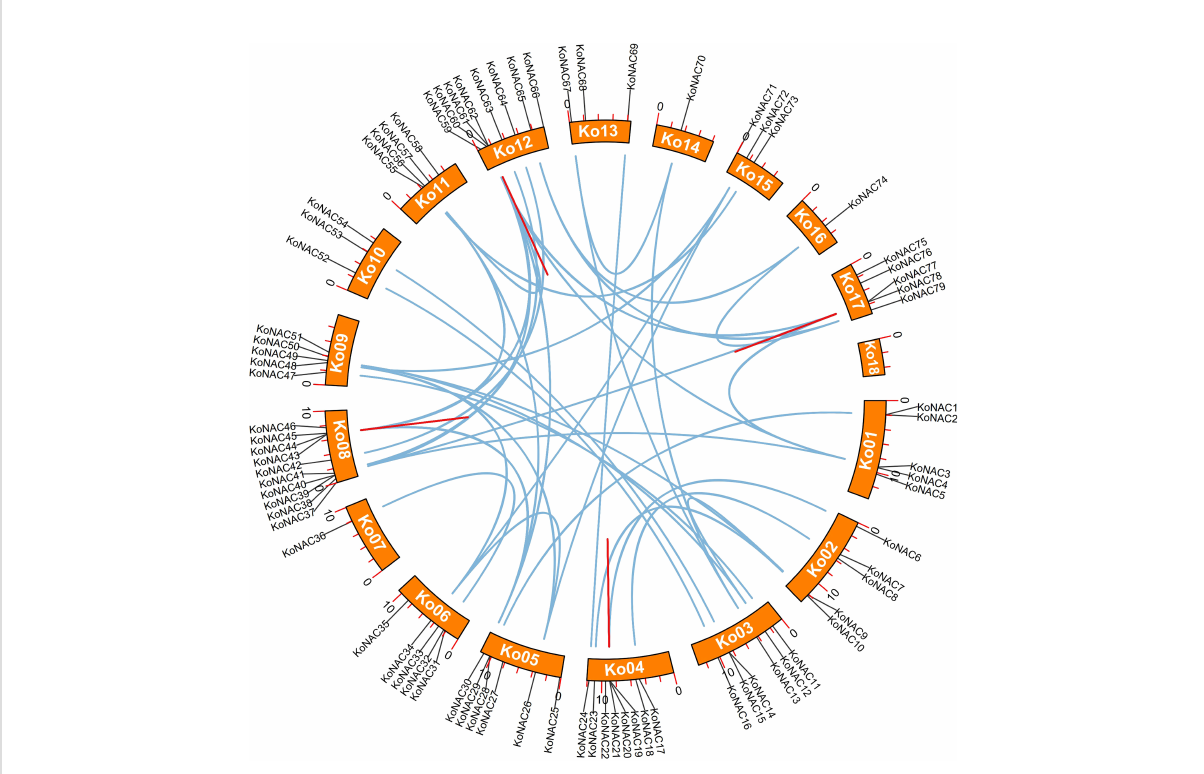
FIGURE 4 Schematic representations of the interchromosomal relationships of KoNAC genes. The blue lines indicate segmentally duplicated KoNAC gene pairs, and the red lines indicate tandemly duplicated KoNAC gene